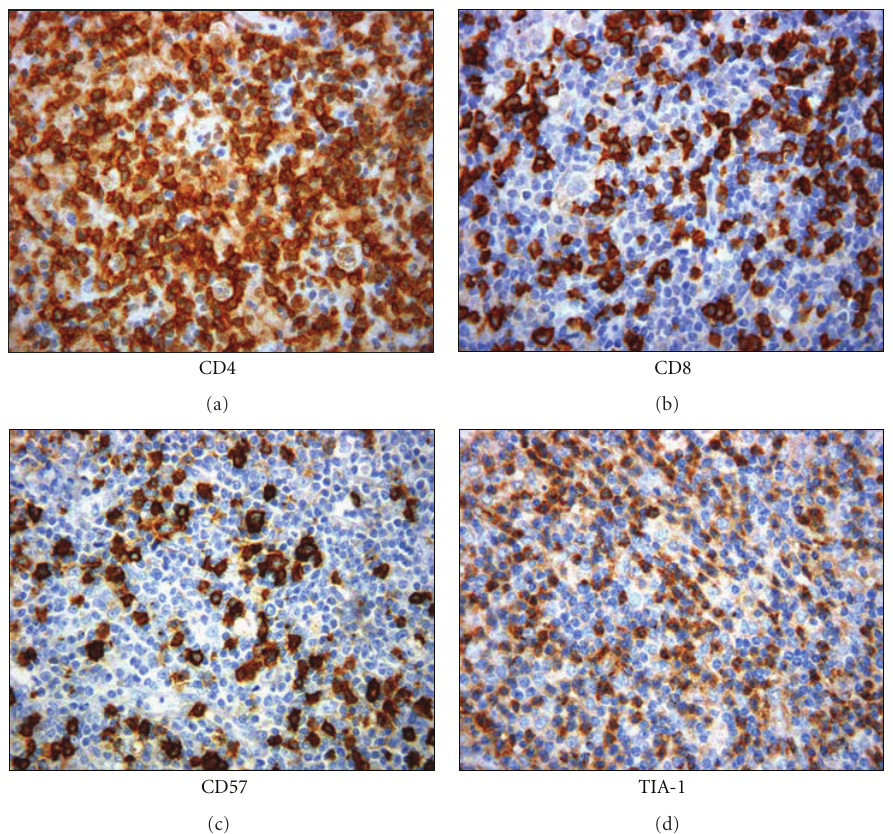
Figure 1: Immunohistochemical staining of inflammatory background in HL: T lymphocytes (CD4 and CD8), NK cells (CD57), and cyto- toxic cells